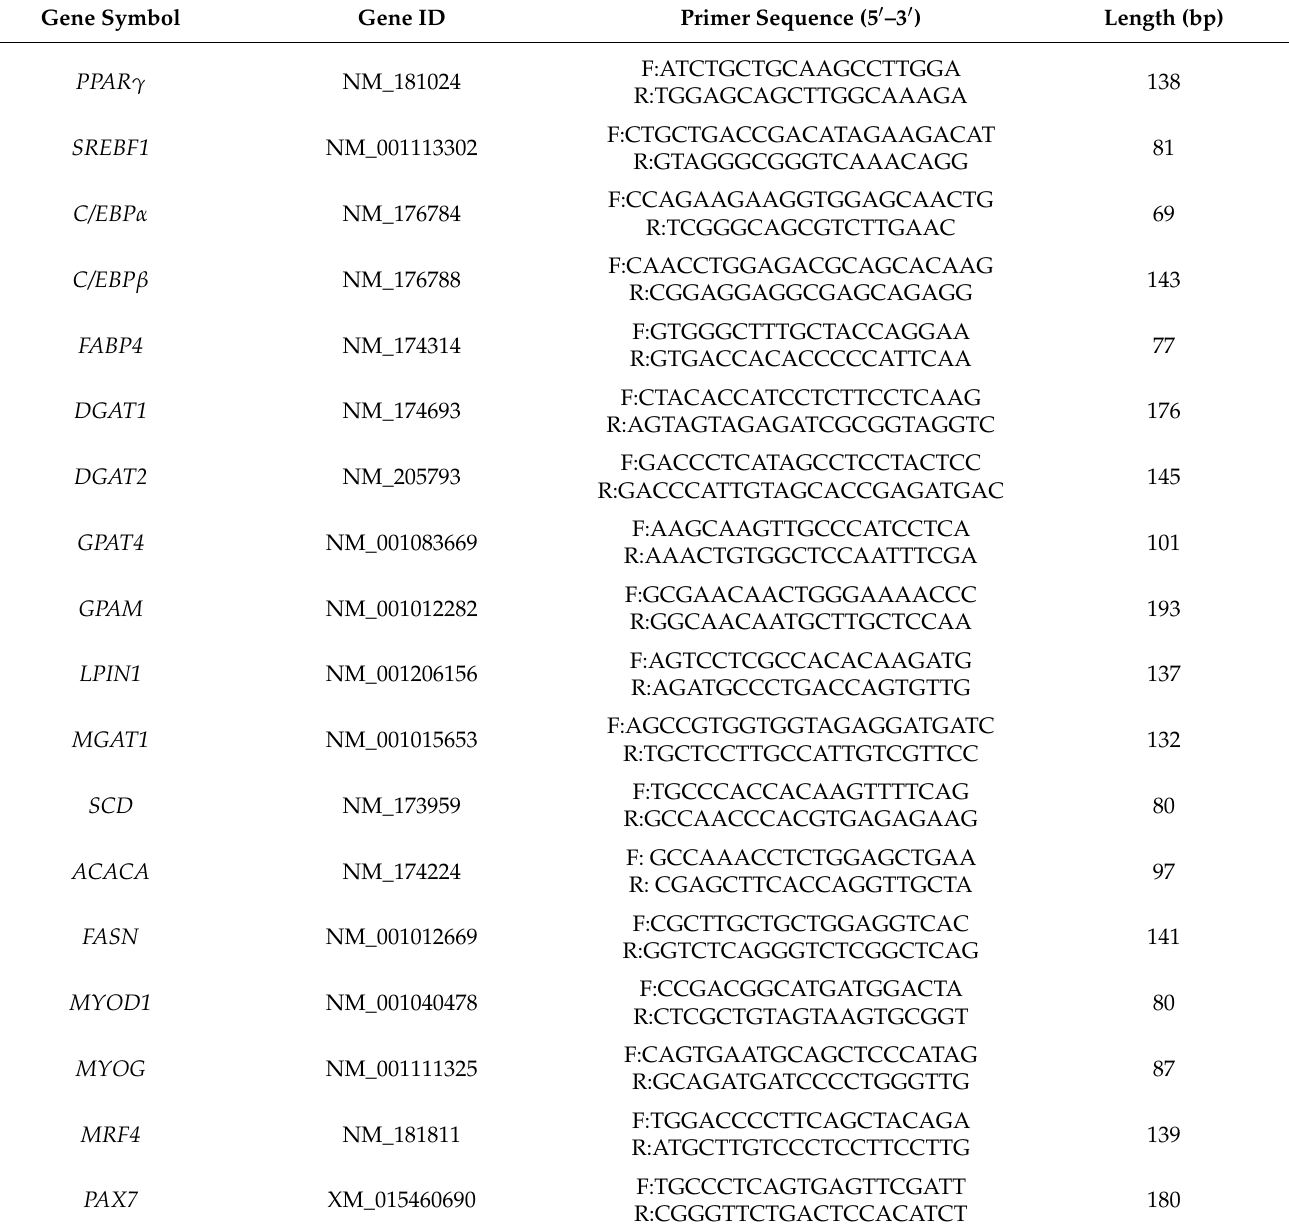
Table 2. Primers used for quantitative real-rime